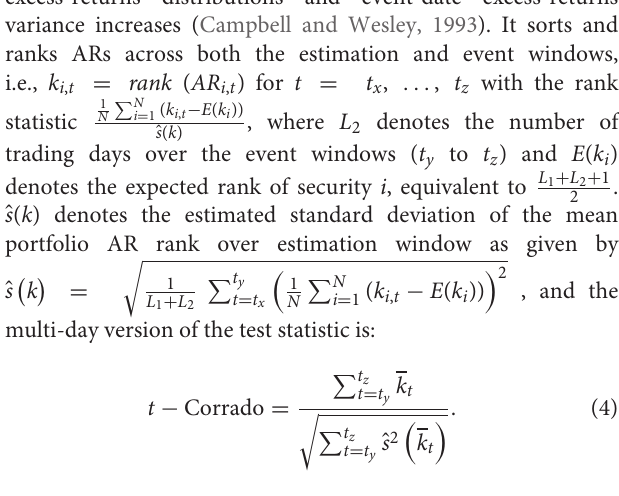
TABLE 1 | Short-term abnormal